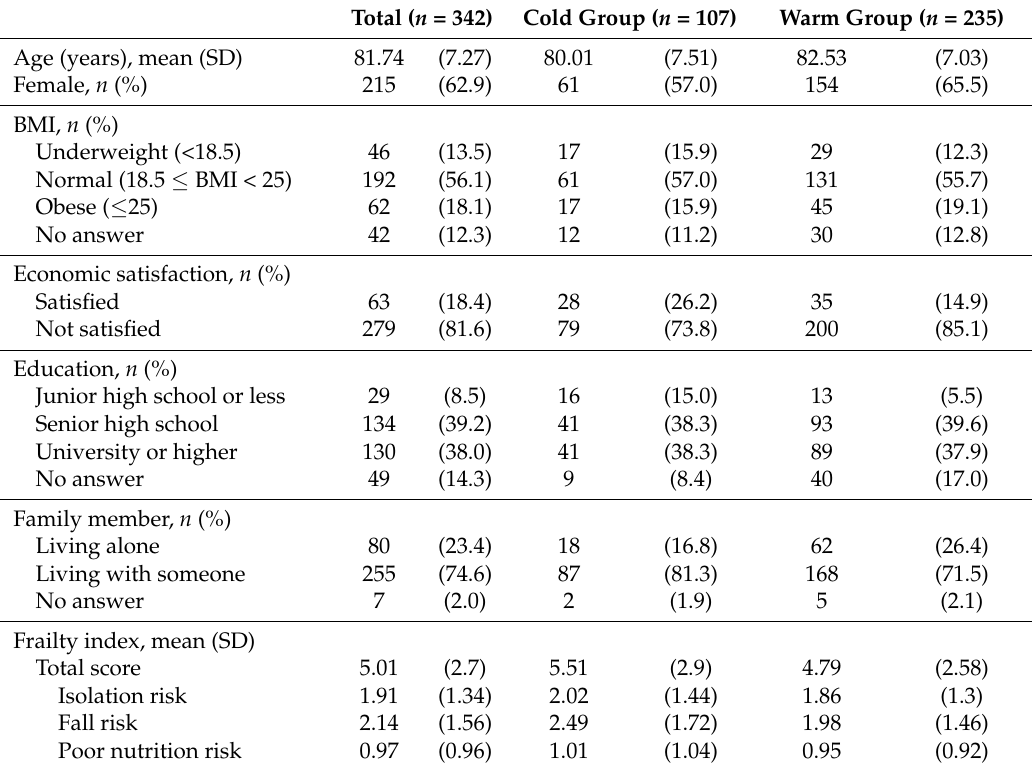
Table 2. Participant characteristics by perceived indoor temperature and for total sample ( n =